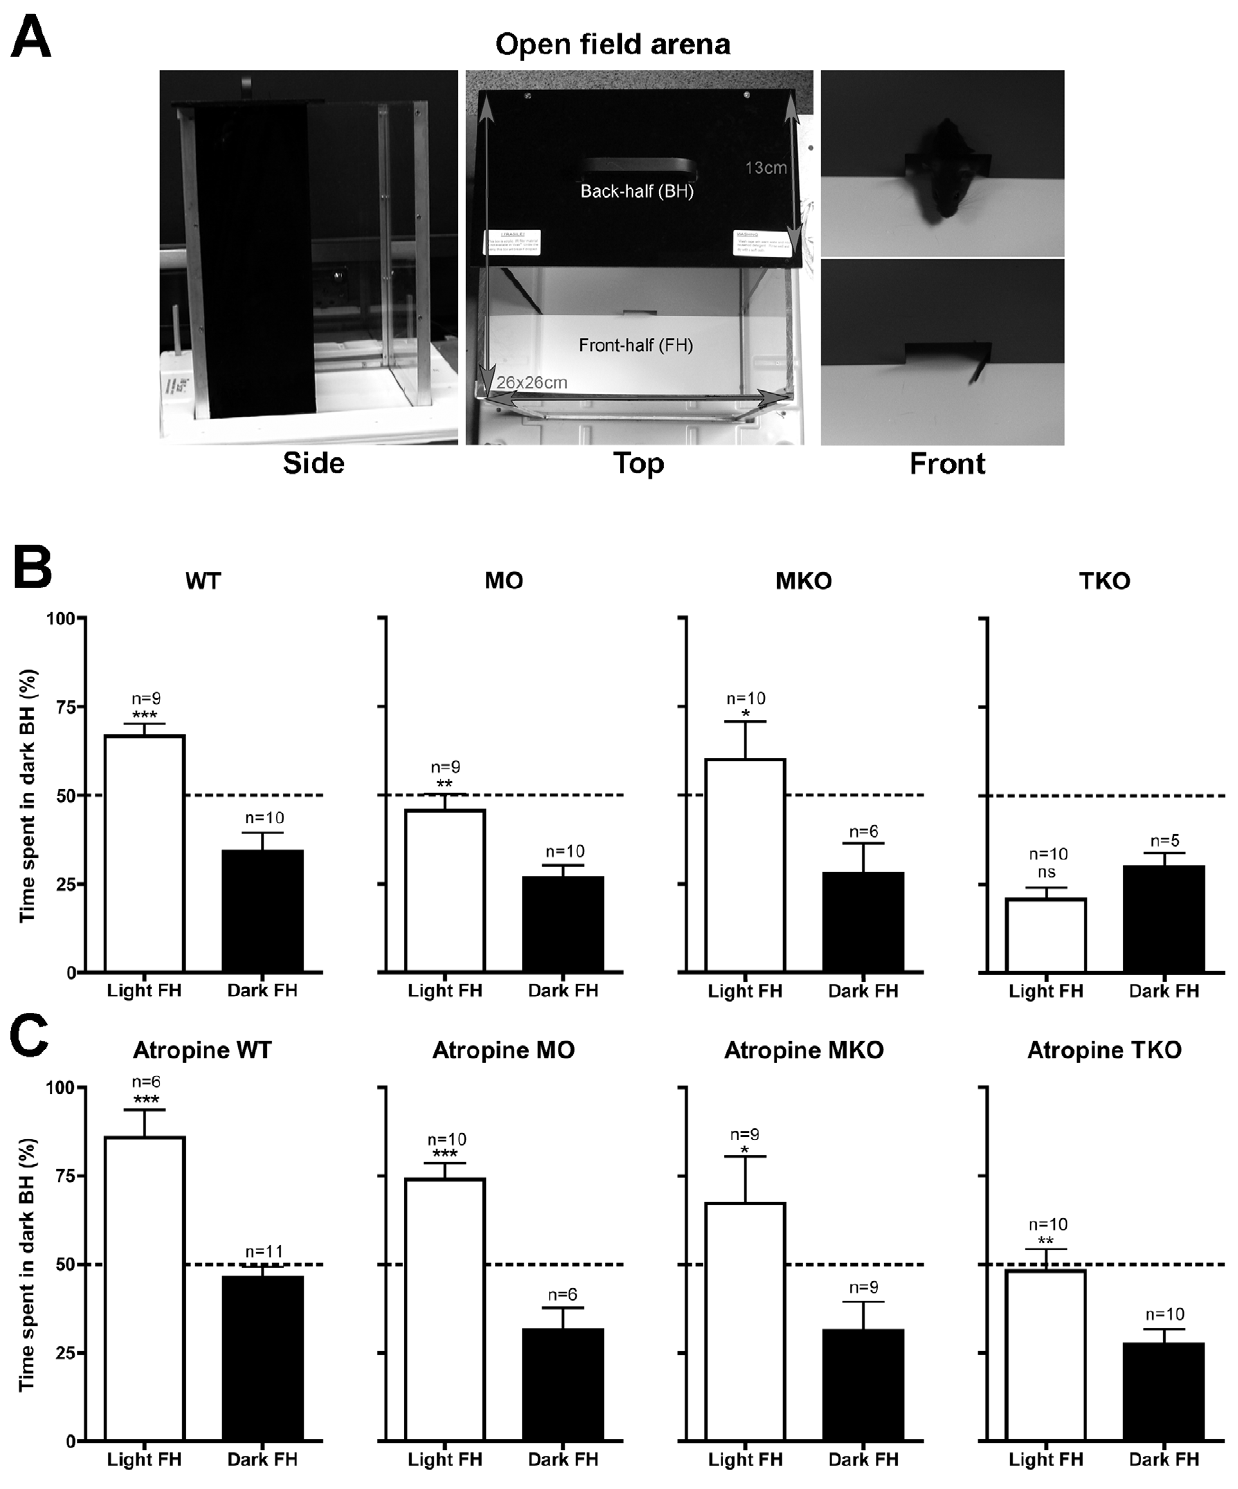
Figure 1. Role of melanopsin in the behavioural aversion to light in mice. ( A ) Open field apparatus: animals were placed into the front-half (FH) of the arena and remained there for 30 minutes. Time spent in the back-half (BH) of the arena was recorded. (B) and (C) Average ( 6 SEM) percentage of time spent in the dark BH of the arena during the 30-minute trial. The FH is either illuminated, white bars (light FH), or in darkness, black bars (dark FH). ( B ) In untreated animals photophobic behaviour is evident in wildtype (WT), melanopsin only (MO) rd/rd cl mice, and melanopsin knockout (MKO) mice. Triple knockout (TKO) mice, lacking melanopsin and functional rods and cones show no aversion to light. ( C ) Atropine significantly increases aversive behaviour in WT, MO, and TKO mice. In MKO mice, atropine increases the average aversive behaviour but this does not reach significance. Atropine does not significantly affect behaviour when the FH is in darkness in any of the genotypes. Stars (*) indicate significance levels (Student’s t -test): * p , 0.05; ** p , 0.01; *** p , 0.001.